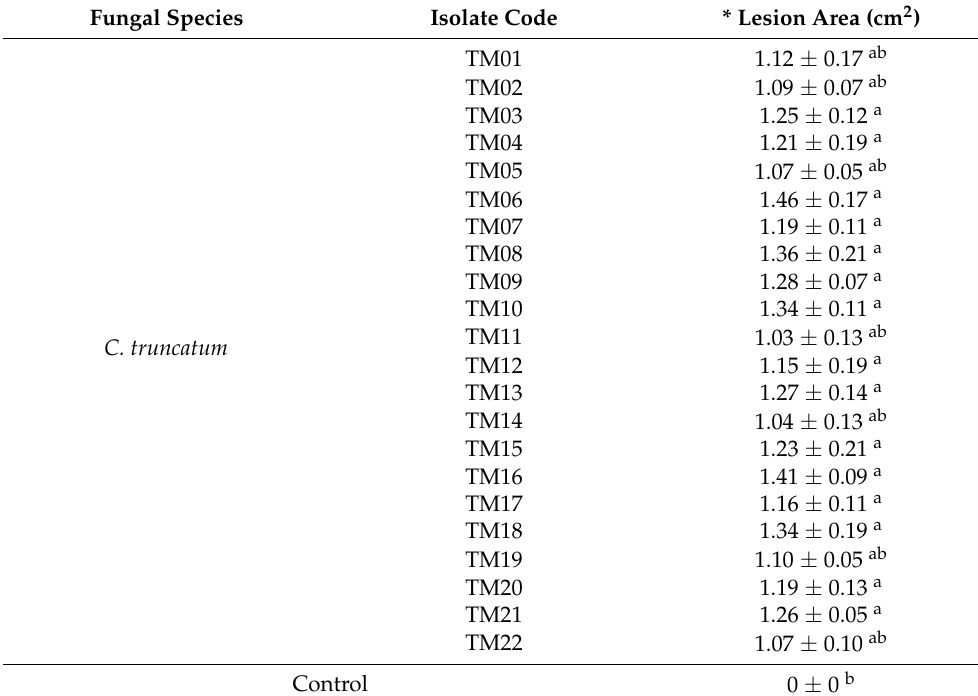
Table 3. Lesion areas produced by C. truncatum isolates on inoculated fruits of tomato. Fungal Species